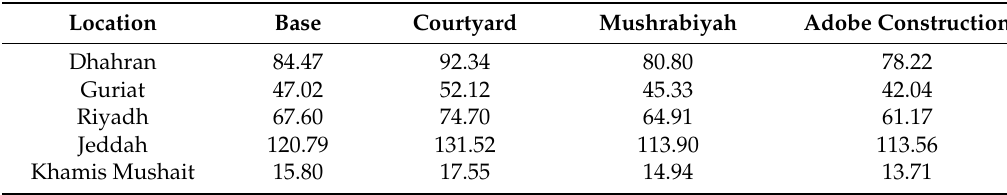
Table 8. The annual demand for HVAC load in kWh/m 2